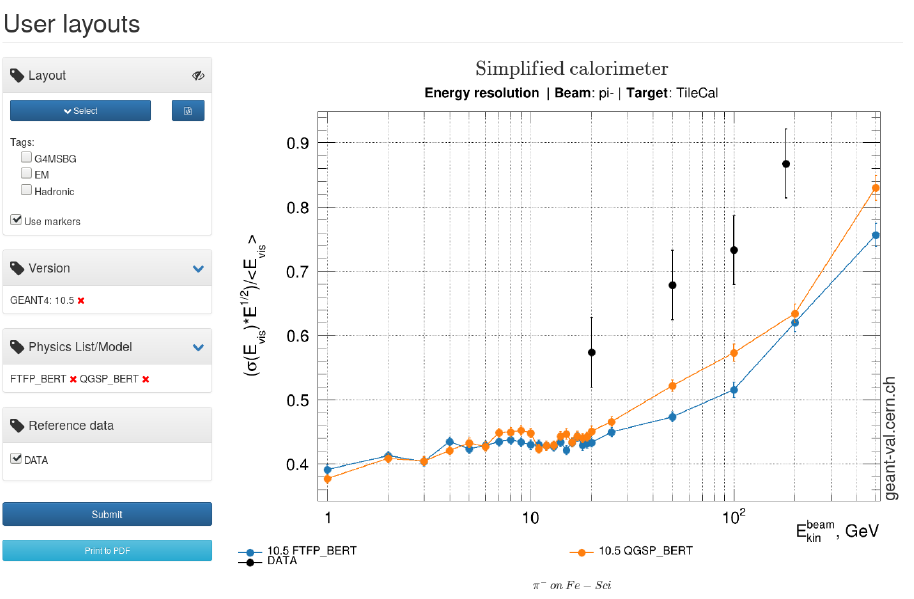
Figure 4. Layout for the Geant4 "simplified calorimeter" test with results for Geant4 reference releases 10.4.ref07, 10.4.ref08 and physics lists FTFP_BERT and